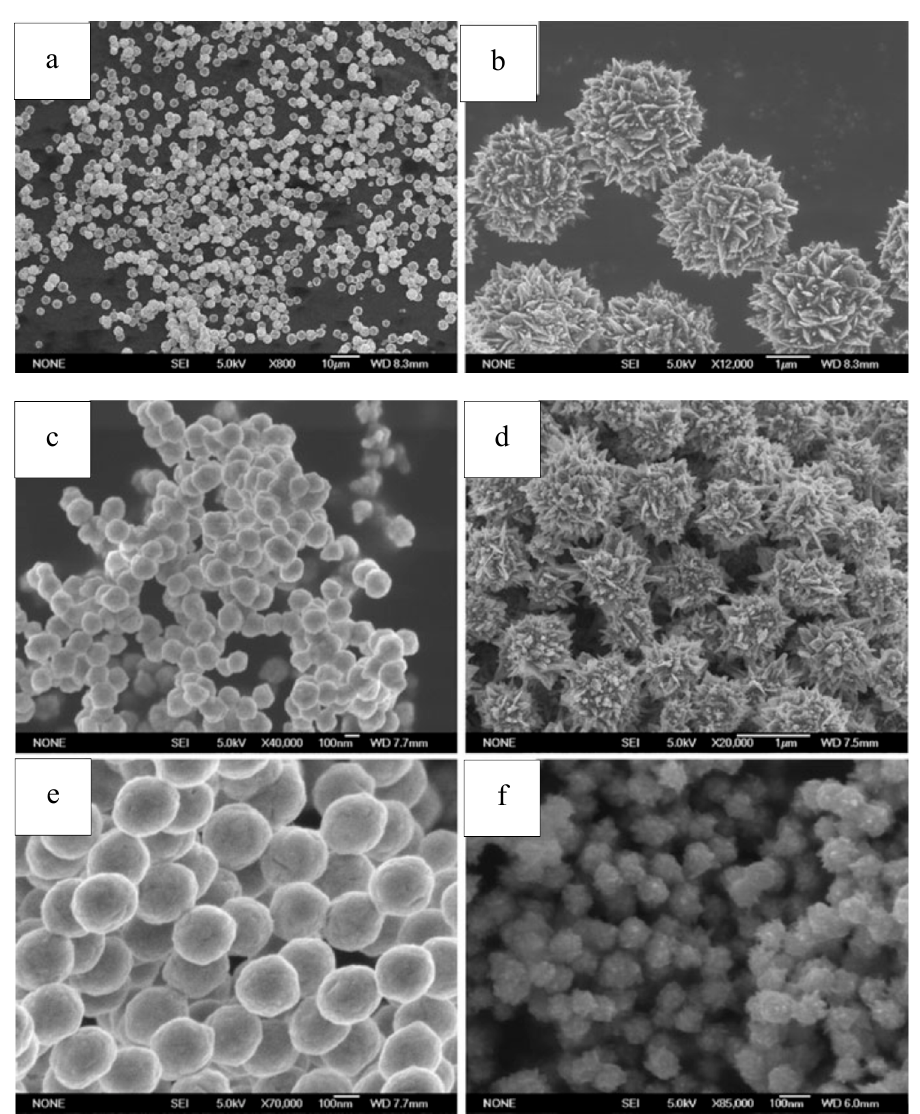
Figure 9. SEM of Ni particles from our work ( a - b . Ni obtained using hydrazine hydrate as reducing reagent, with no surfactant introduced; ( c ). Ni obtained when excessive NaOH (NaOH/Ni = 2.5) was used; ( d ). Ni obtained when the molar ratio of N 2 H 4 /Ni was raised to 6 and no NaOH was added; e. Ni obtained when ethylene glycol was used; f. Ni obtained when ethanol was used). Reproduced with permission [164]. Copyright 2012, Springer.